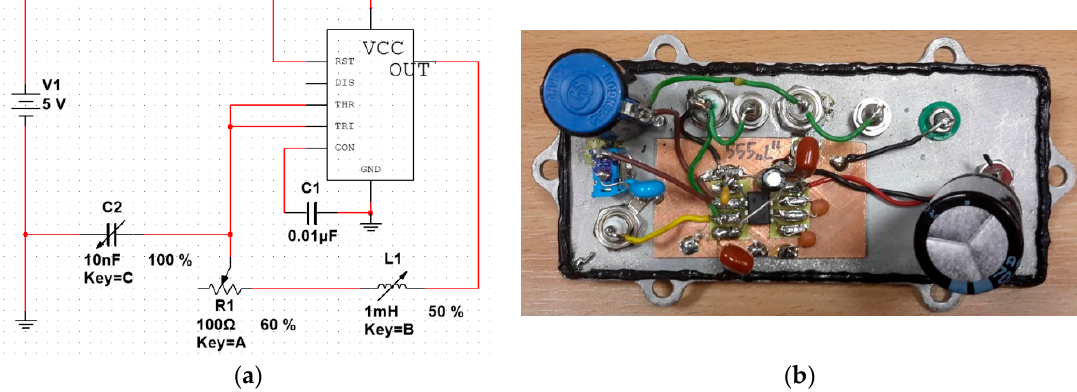
Figure 2. ( a ) Astable 555 circuit sensitive for impedance changes. Element L1 is the sensor’s impedance, connected in the feedback loop to the frequency range setting capacitor C2. This capacitor is chosen experimentally to obtain ~100 kHz transducer output for the given sensor. R1 is series variable resistance, which can be adjusted to tune the transducer characteristic—it is not needed for most applications. ( b ) Photo of prototype unit with additional input/output connectors and selectable range setting capacitors C2.